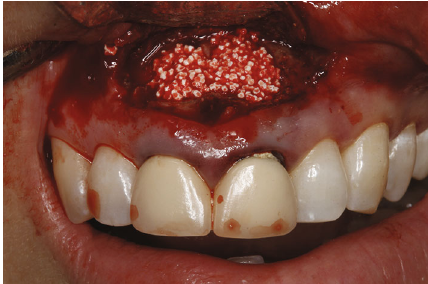
Figure 16: Regeneration of the defect with a synthetic bone graft.